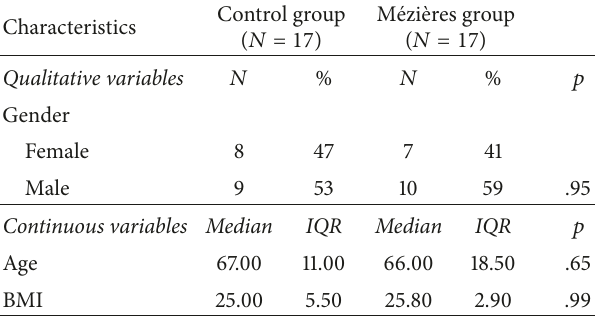
Table1:Characteristicsofthegroupswithregardtogender,age,and BMI (body mass index) at baseline (median and IQR, frequencies, and